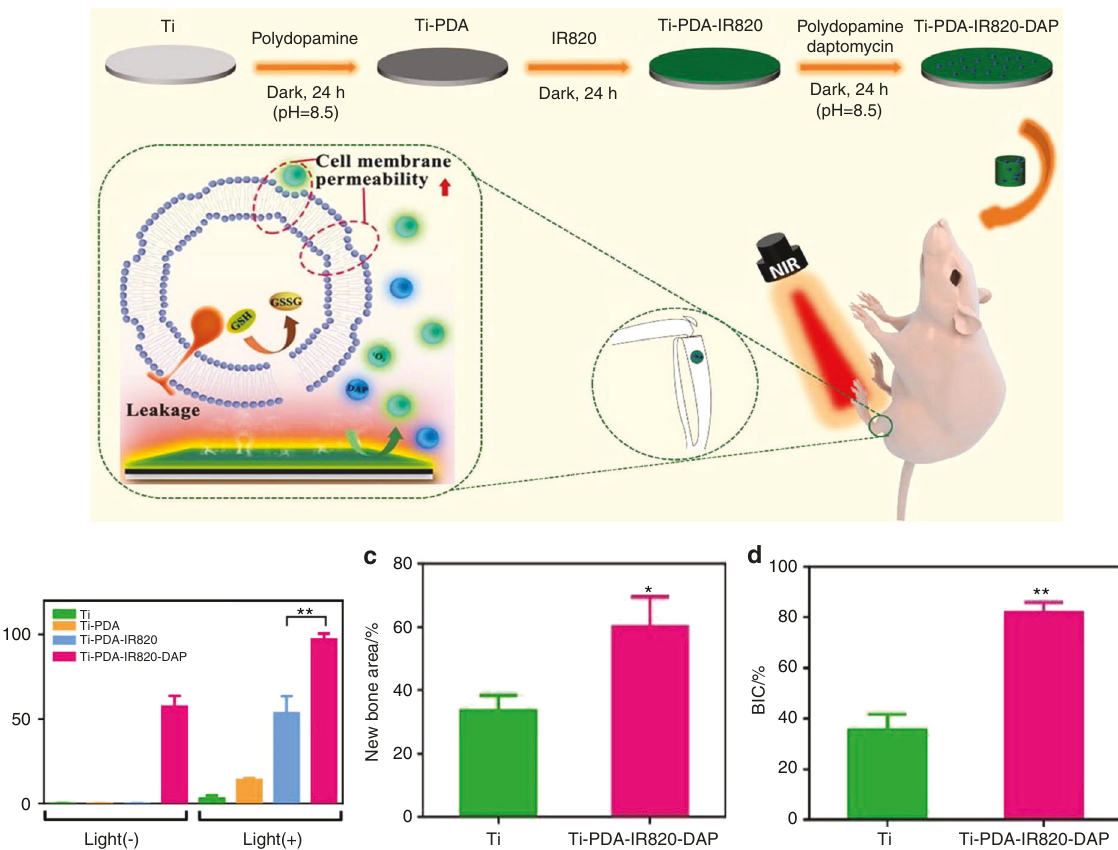
Fig. 4 A novel biocompatible PDA/IR820/DAP coating for antibiotic/photodynamic/photothermal triple therapy. a Scheme of the antibacterial mechanism of Ti-PDA-IR820-DAP: the synergistical therapy of DAP, PTT, and PDT cause remarkable lethal effect to bacteria. b The results of spread plate assays to show the antibacterial ef fi ciency. c Quantitative analysis of new bone area. d The percentages of bone-implant contact (BIC) were calculated from Van Gieson staining. Reproduced with permission. 56 Copyright 2020,